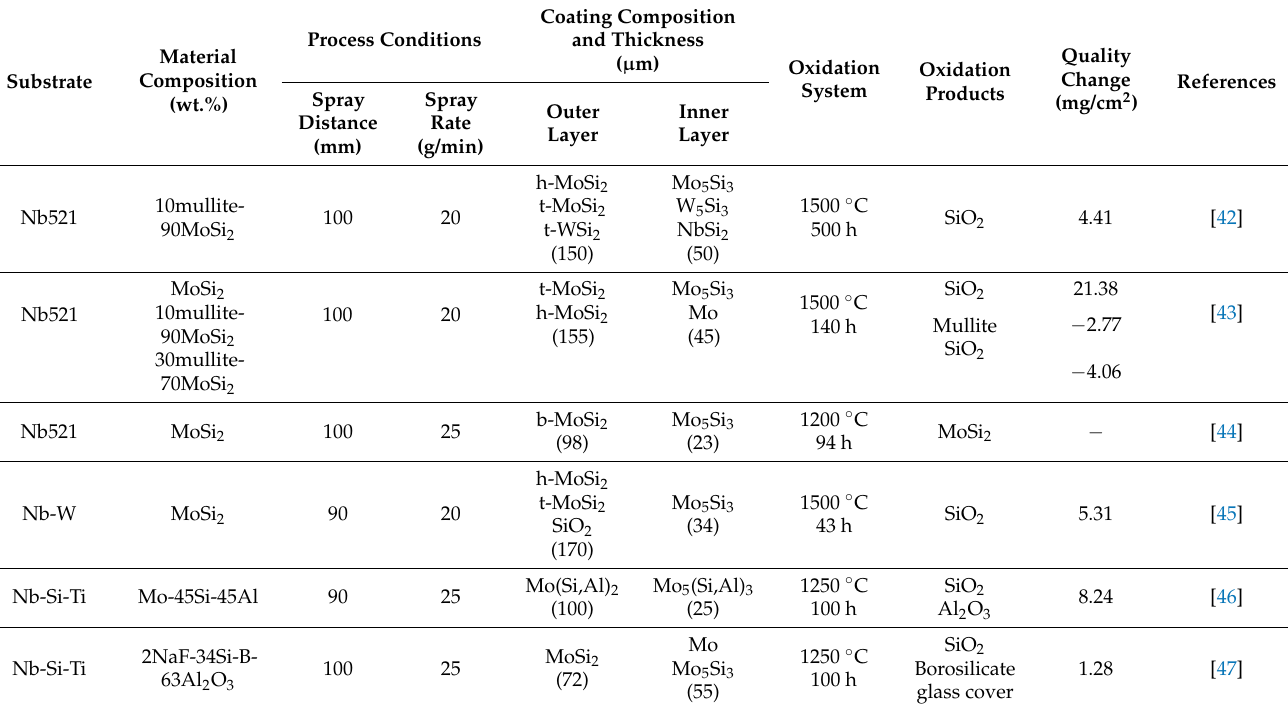
Table 2. Summary for preparation and oxidation resistance of SPS coatings on Nb-based alloys.